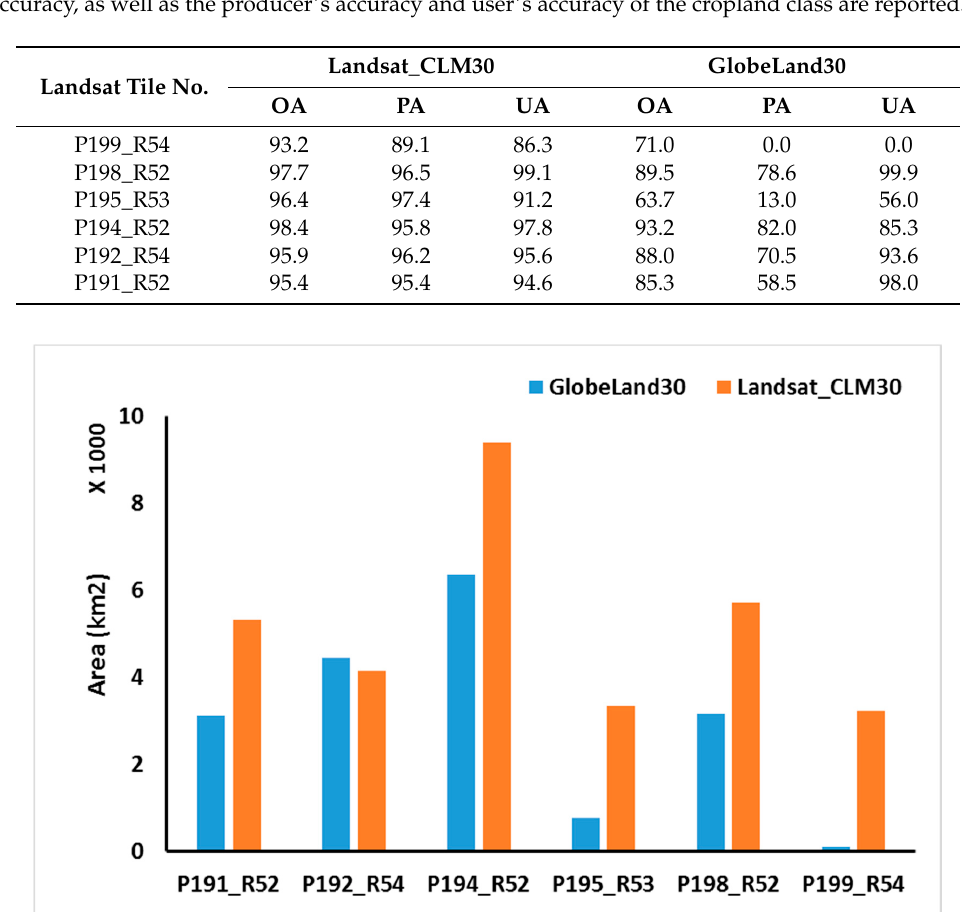
Figure 6. Comparison between cropland area derived from Landsat_CLM30 and GlobeLand30.